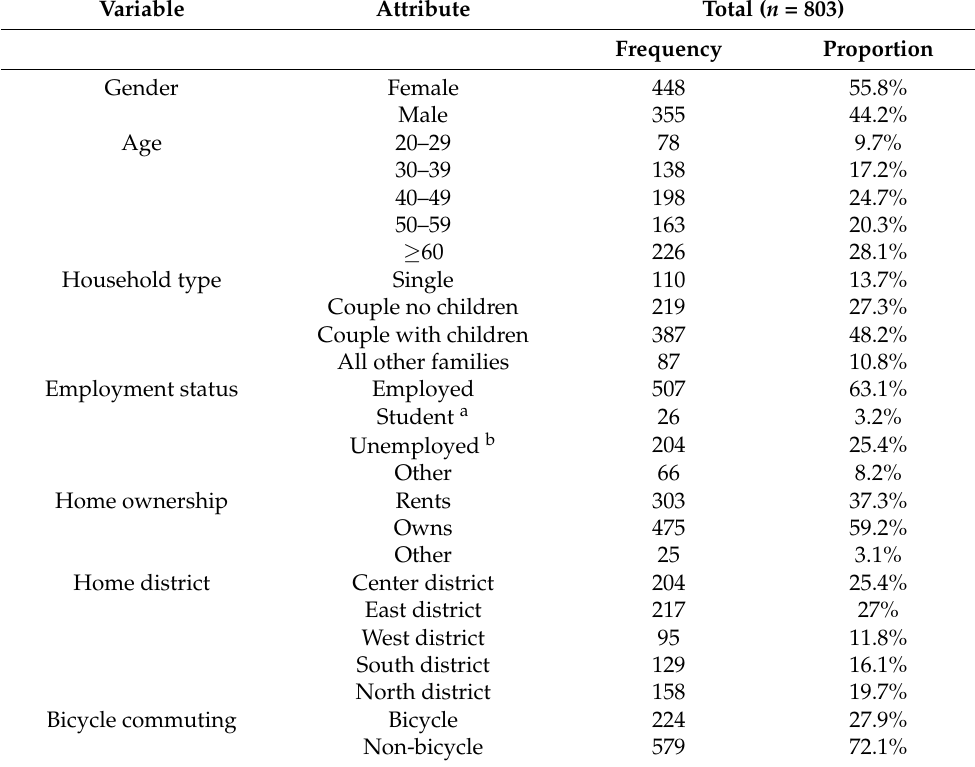
Table 2. Demographic characteristics of